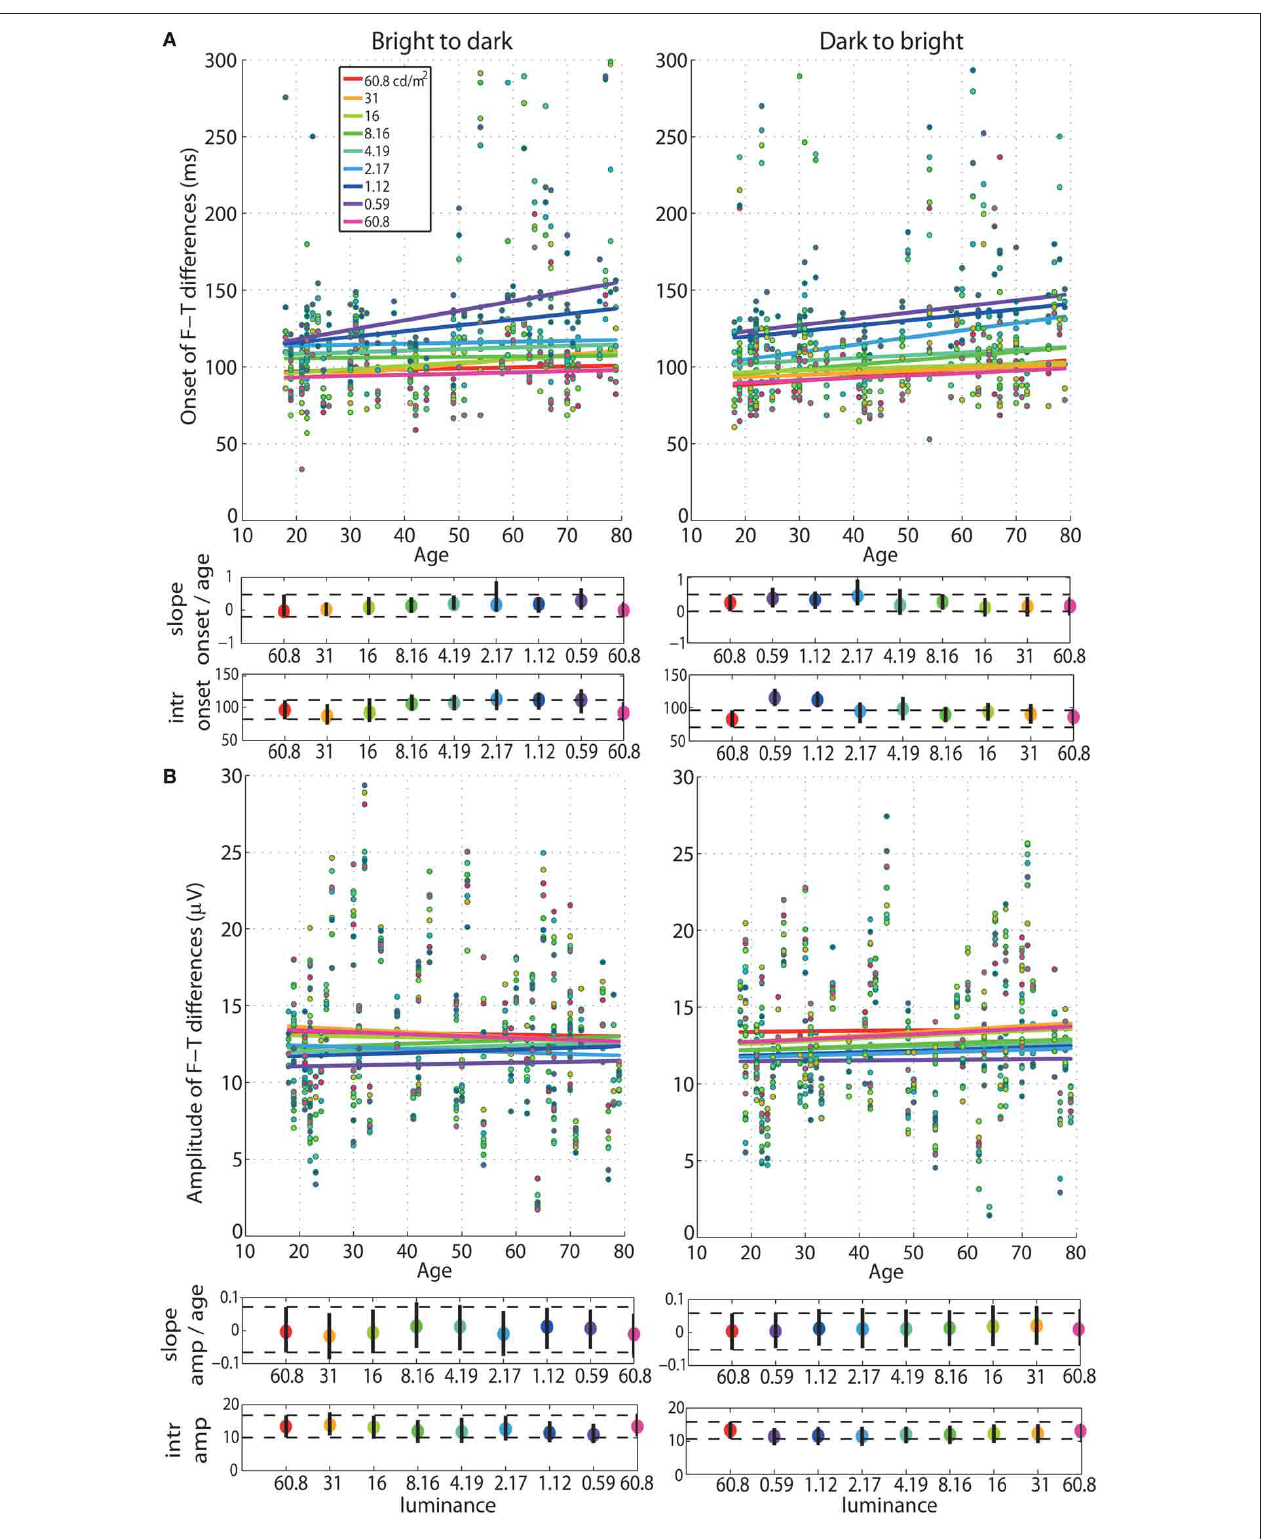
FIGURE 4 | Regressions of onset and amplitude ERP differences against age. (A) Regression fits between the onset of significant face-texture ERP differences and age and (B) between maximum amplitude of face-texture ERP differences and age, for all luminance levels.